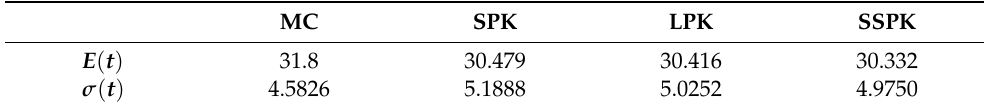
Figure 4. Histogram of times for the fifth case study. Table 9. Mean and variance of times for the fifth case study.